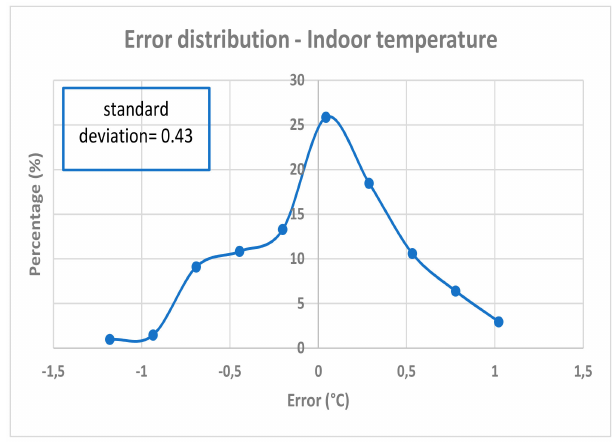
Figure 12. Predicted and recorded indoor temperatures: ( a ) the variation of both temperatures in time domain; and ( b ) the predicted indoor temperature with the recorded indoor temperature.